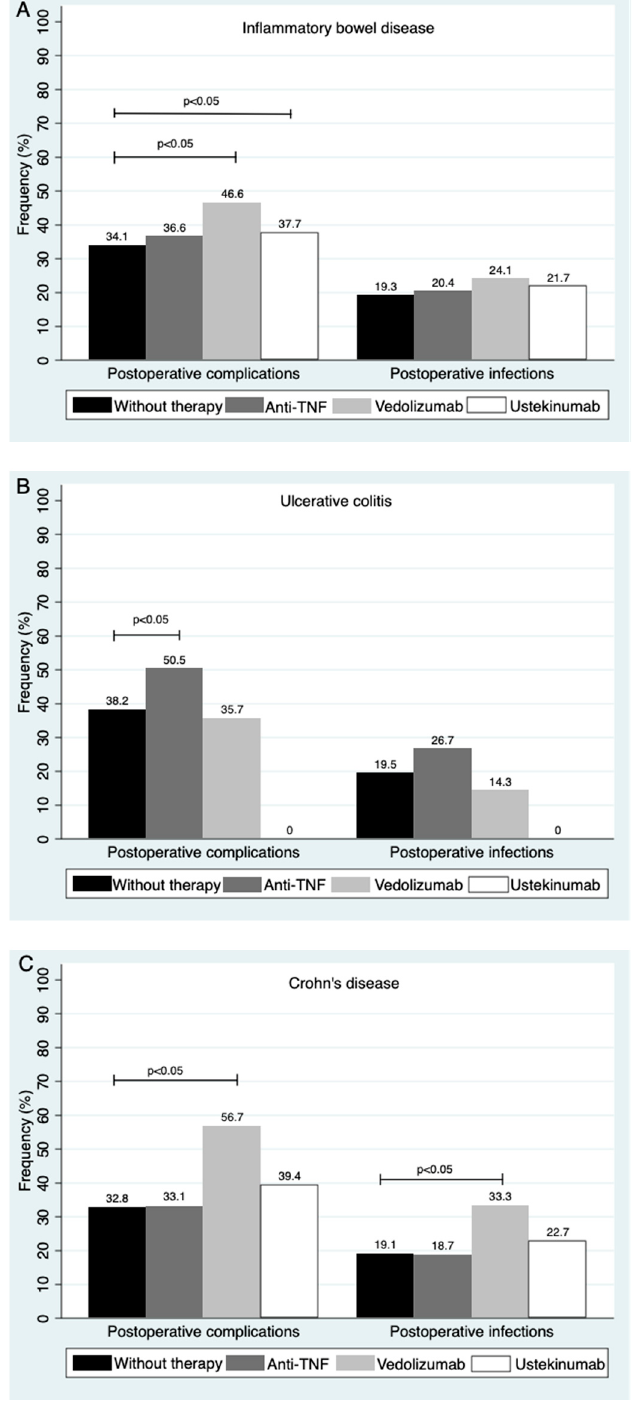
Figure 1. Effect of biological treatment during the preoperative period on frequency of postoperative complications and infections by Chi-square test. ( A ), Inflammatory bowel disease. ( B ), Ulcerative colitis. ( C ), Crohn’s disease. Statistically significant differences ( p ≤ 0.05) are indicated in the graphic.